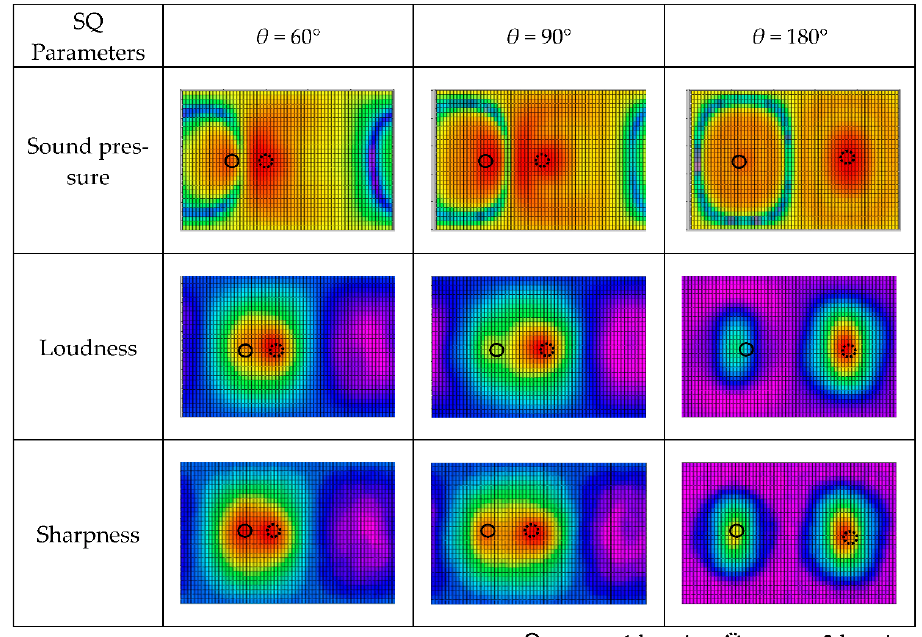
Figure 8. Spatial distributions of sound quality objective parameters for source reconstruction distance r = 0.1 m at different sound frequencies. (The results are shown in the form of plane expansion of the spherical calculation surface, and the horizontal axis is longitude: −π ~ π , the vertical axis is latitude: −π /2~ π /2).